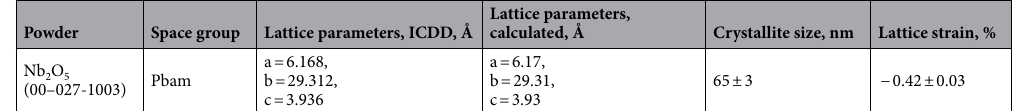
Powder Space group Lattice parameters, ICDD, Å